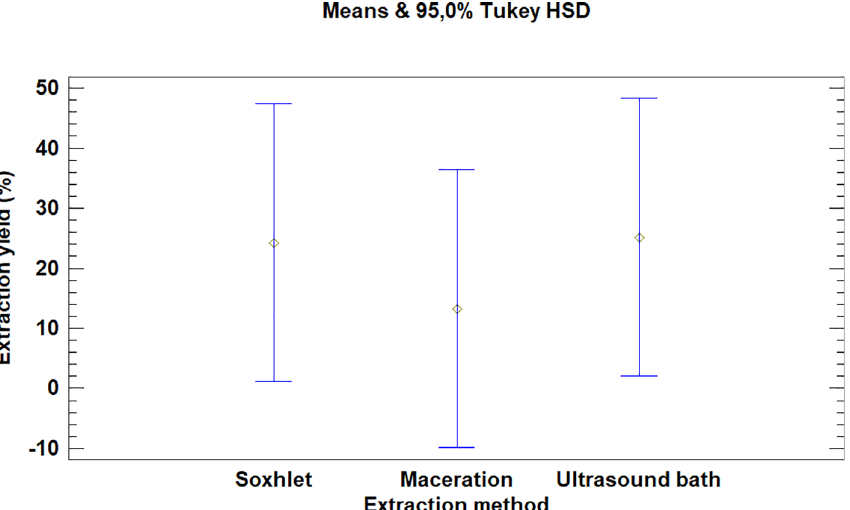
Figure 4. Comparison of Tukey means for yields of Bidens pilosa L. extracts according to the extraction process.